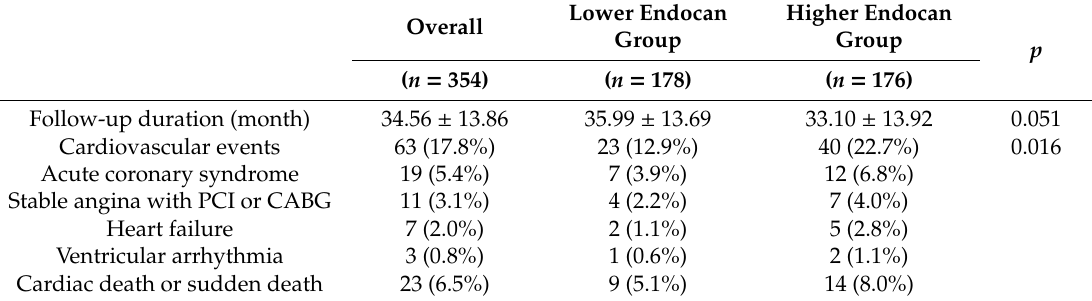
Table 3. Clinical outcomes according to plasma endocan level.